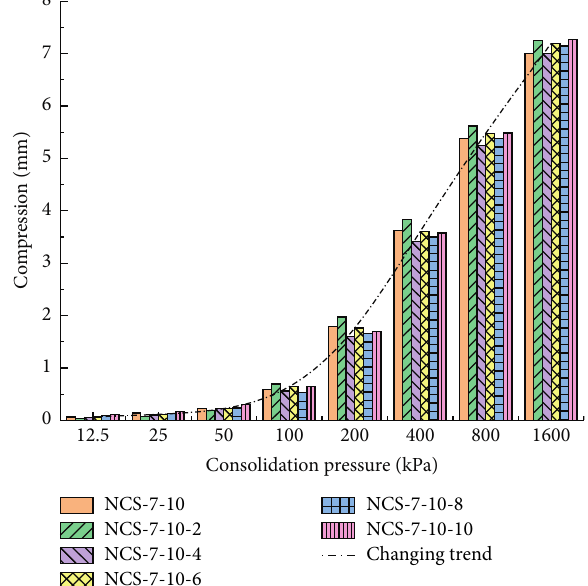
Figure 9: d - p histogram of NCS-7 with different consolidation pressure.